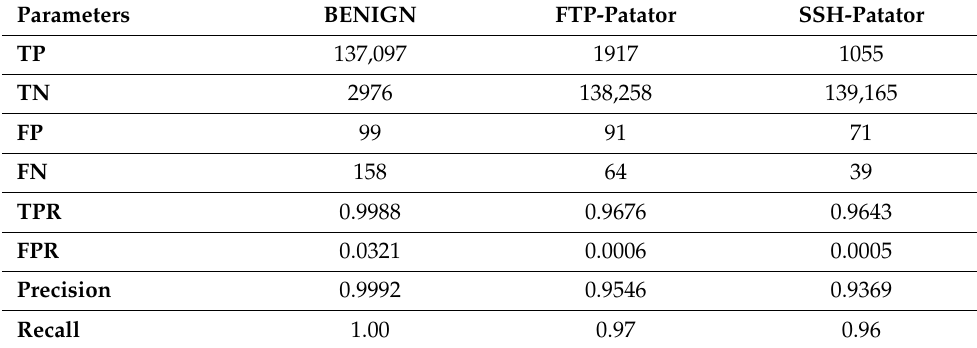
Table 5. Statistical report of Wednesday test